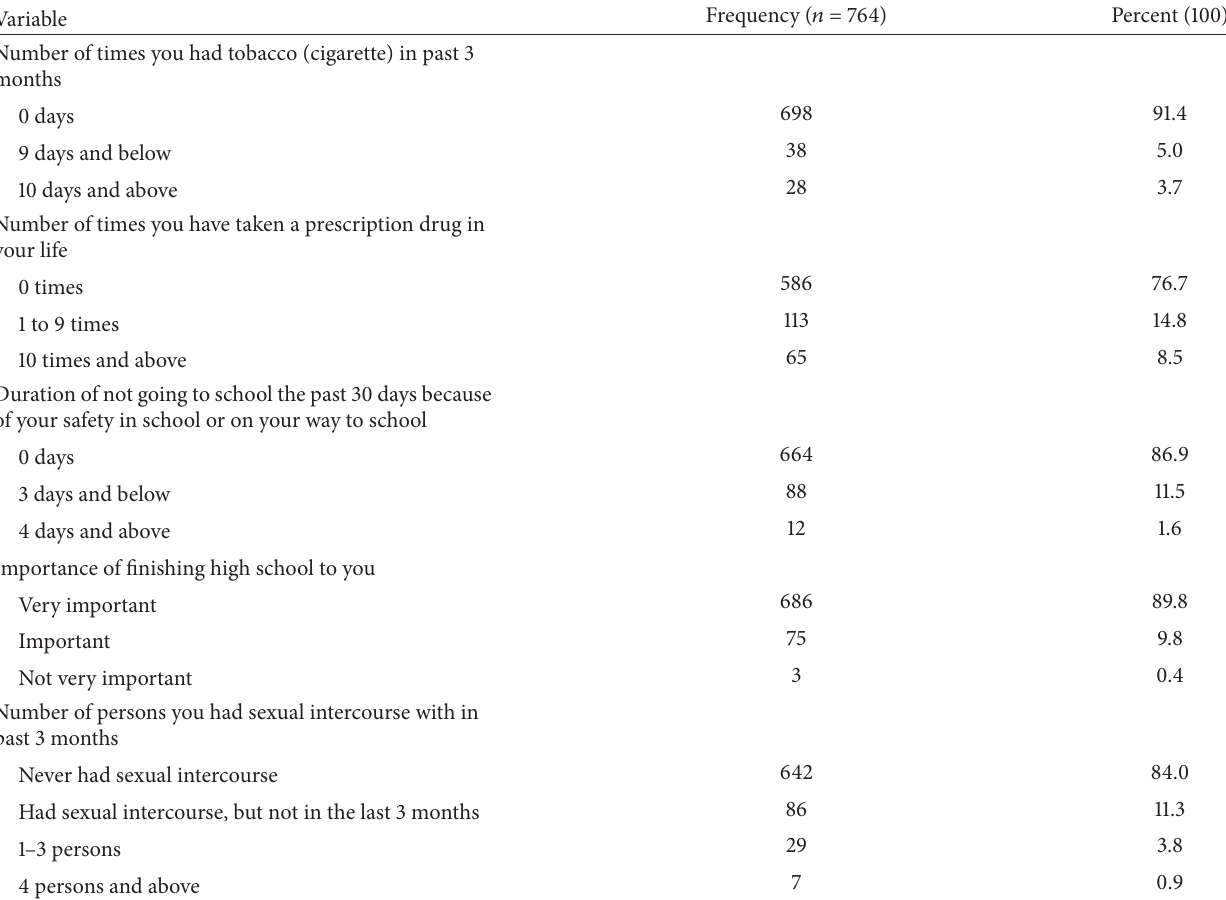
Table 2: Frequency distribution of the respondents by adolescent problems and specific manifestation of behavioral